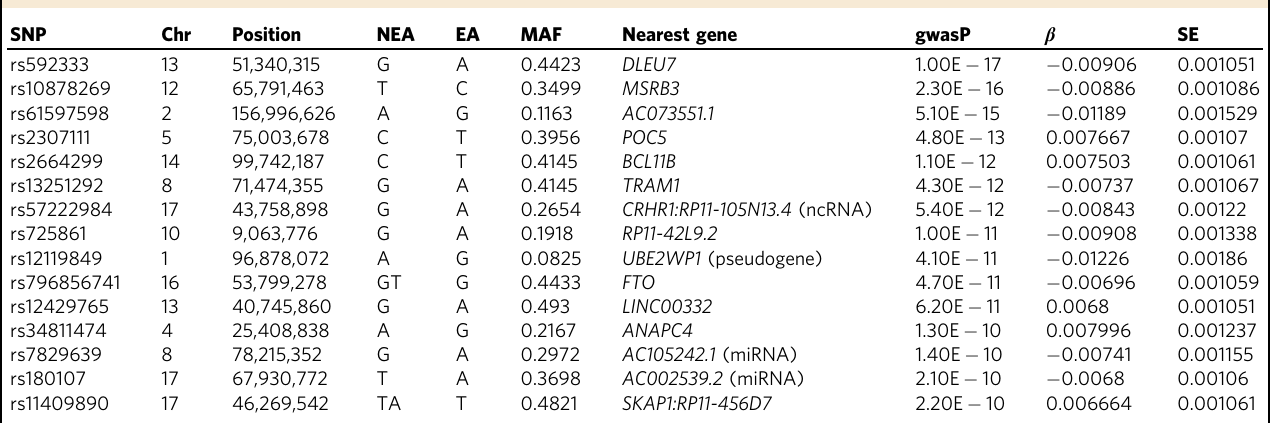
Table 2 Top 15 genomic risk loci for snoring showing the top SNP for each locus.